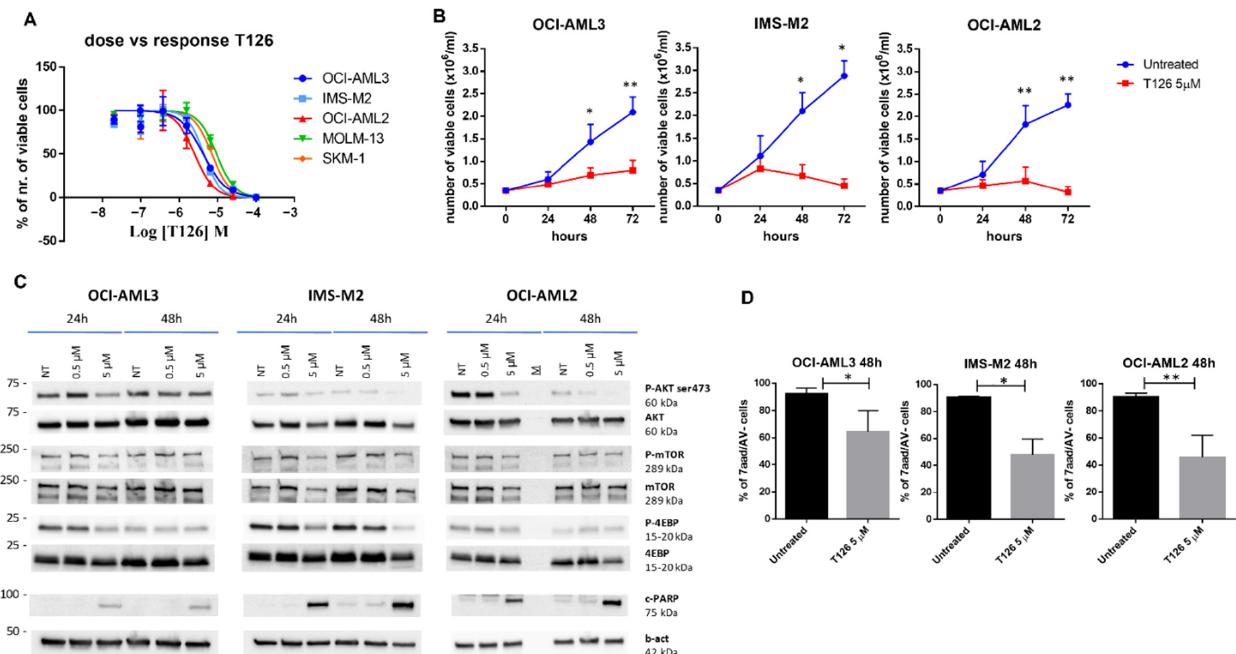
Figure 4. T126 induces growth arrest and apoptosis in AML cells. ( A ) T126 dose-response curves as generated by CellTiter Blue assay for the human AML cell lines OCI-AML3, IMS-M2, OCI-AML2, MOLM-13, and SKM-1. ( B ) T126 induced a significant cell growth inhibition on OCI-AML3, IMS-M2, and OCI-AML2, at 48 and 72 h from the start of the treatment at a 5 µ M dose (student paired t -test, 48 h p = 0.02 and 72 h 0.006, 48 h p = 0.04 and 72 h p = 0.01, and 48 h p = 0.006 and 72 h p = 0.004, respectively). ( C ) The effects of T126 at a 0.5 and 5 µ M dose on phosphorylation of AKT1 and downstream signaling molecules, namely mTOR and 4E-BP1, at 24 and 48 h, in OCI-AML3, IMS-M2, and OCI-AML2 cells. Activation of the apoptotic signaling molecule cleaved-PARP (c-PARP) under the same experimental conditions. β -actin (b-act) expression levels were used as a control for protein loading. The representative results of at least three independent experiments are shown. All the original blots are reported in Figure S8. ( D ) T126 at a 5 µ M dose induced a significant level of apoptosis (% of Annexin V negative/7aad negative cells) in OCI-AML3, IMS-M2, and OCI-AML2 cells at 48 h (Student paired t -test, where * and ** stand for p = 0.01 and p = 0.005, respectively).